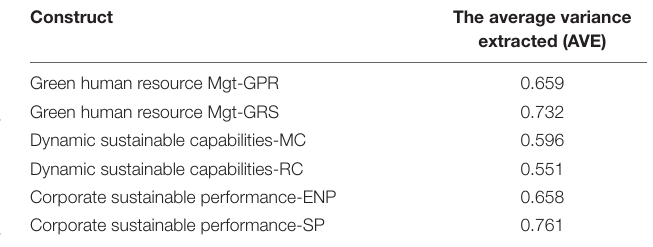
TABLE 3 | Average variance extracted-convergent validity.